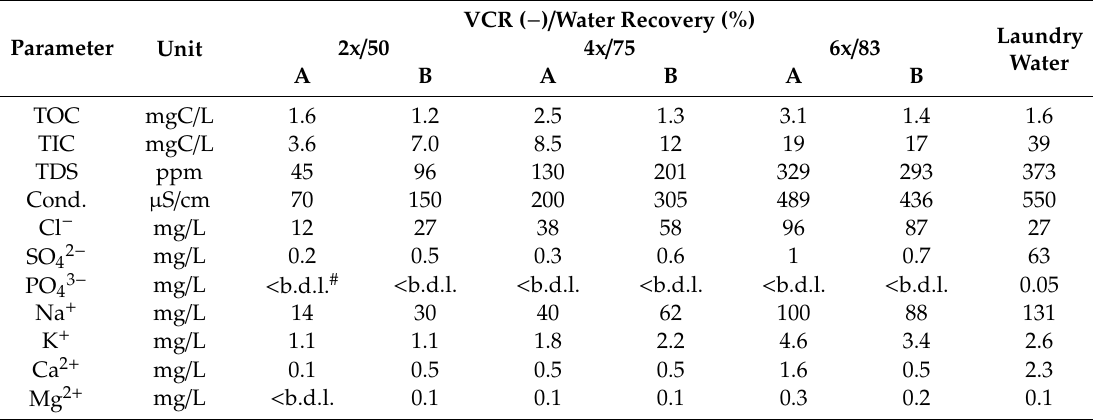
Table 3. Influence of volume concentration ratio on NF permeate quality in system A